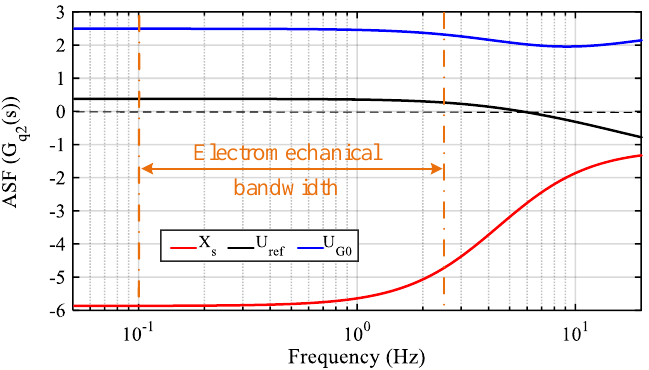
Figure 8. ASF of Gq2(s) with respect to operation parameters.